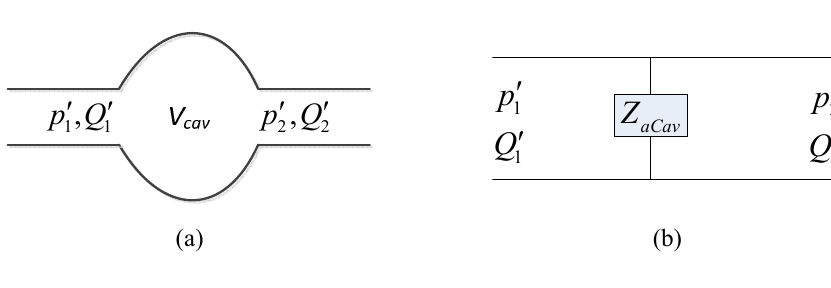
Fig. 8 Schematic for an inline